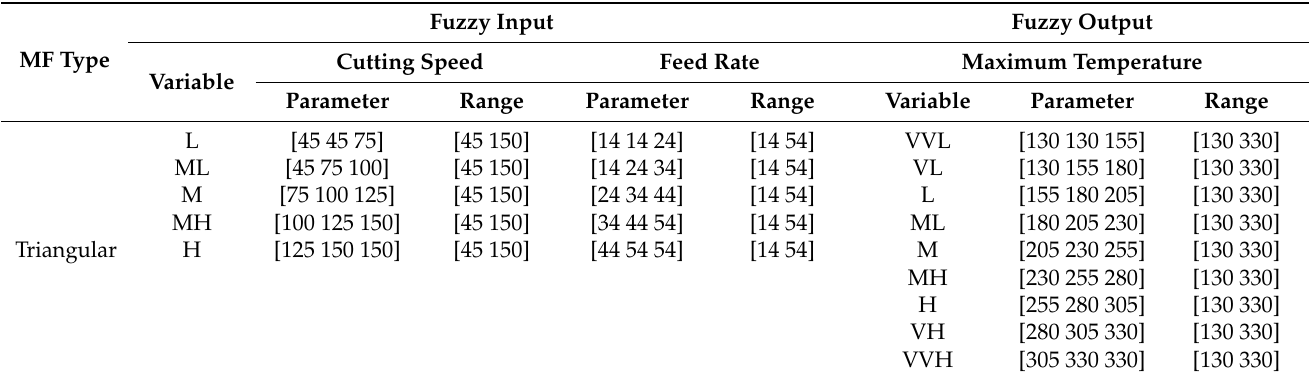
Table 1. Input and output parameters used in fuzzy inference system (FIS).